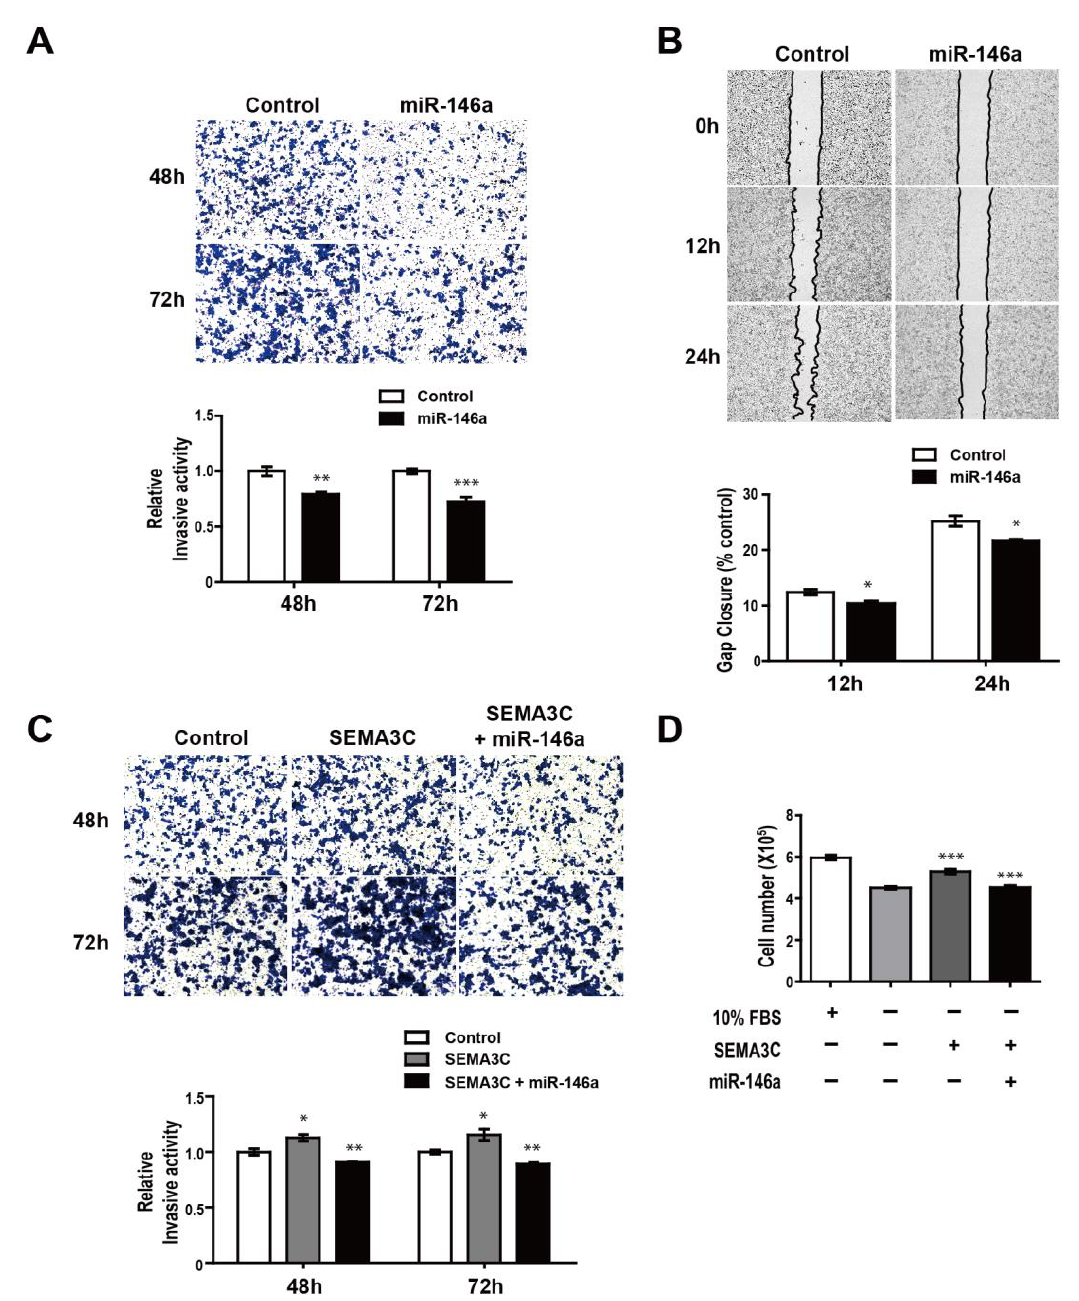
Figure 5. MiR-146a suppression of SEMA3C-induced proliferation and invasion in MDA-MB-468 suspension cells. ( A ) Trans-well invasion assay response to the overexpression of miR-146a in suspension cells. ( B ) Migration assays in adherent cells after the restoration of miR-146a. ( C ) Trans-well invasion assays in response to SEMA3C (50 ng/mL) overexpressed miR-146a or non-overexpression control cultures in suspension cells. ( D ) Cell proliferation assays after treatment with SEMA3C (50 ng/mL) overexpressed miR-146a or non-overexpression control cultures in suspension cells. * p < 0.01, ** p < 0.001, and *** p < 0.0001 compared to controls calculated via an unpaired two-tailed Student’s t -test. Error bars denote the standard error of the